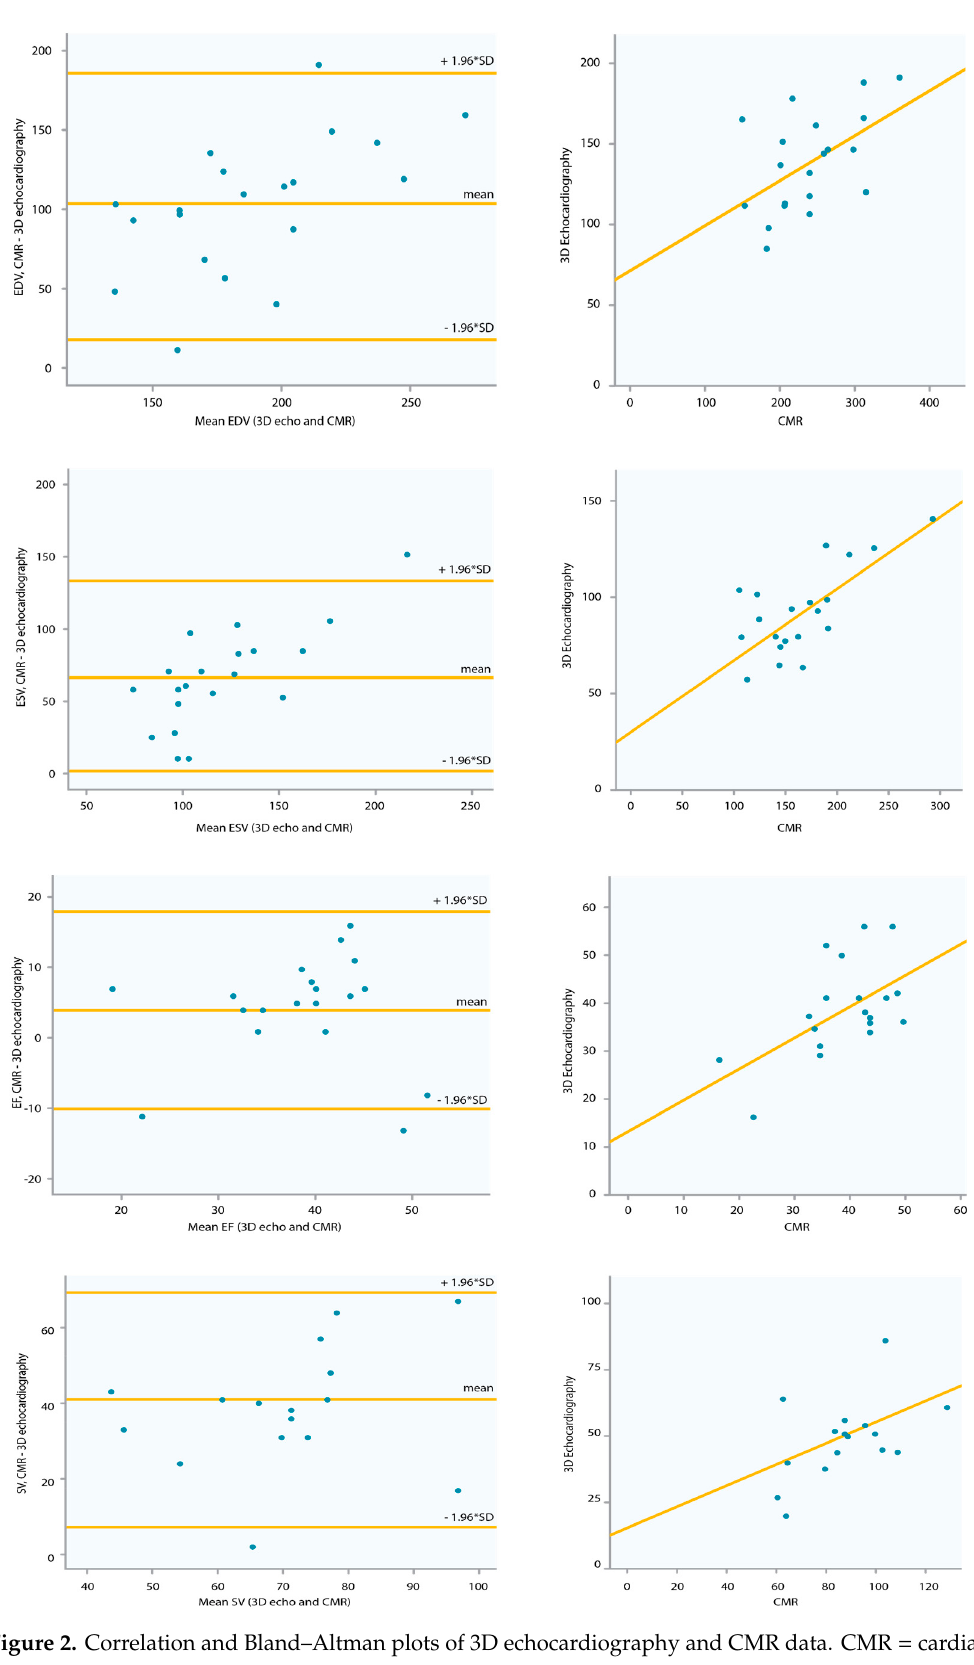
Figure 2. Correlation and Bland–Altman plots of 3D echocardiography and CMR data. CMR = cardiac magnetic resonance imaging. EDV = end-diastolic volume, ESV = end-systolic volume, SV = stroke volume, EF = ejection fraction, SD = standard deviation.